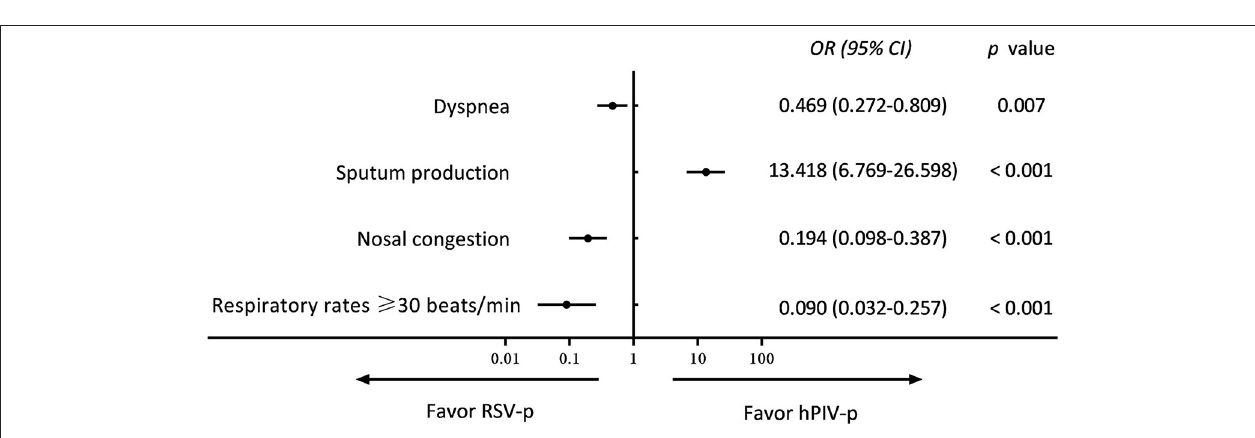
Frontiers in Medicine |